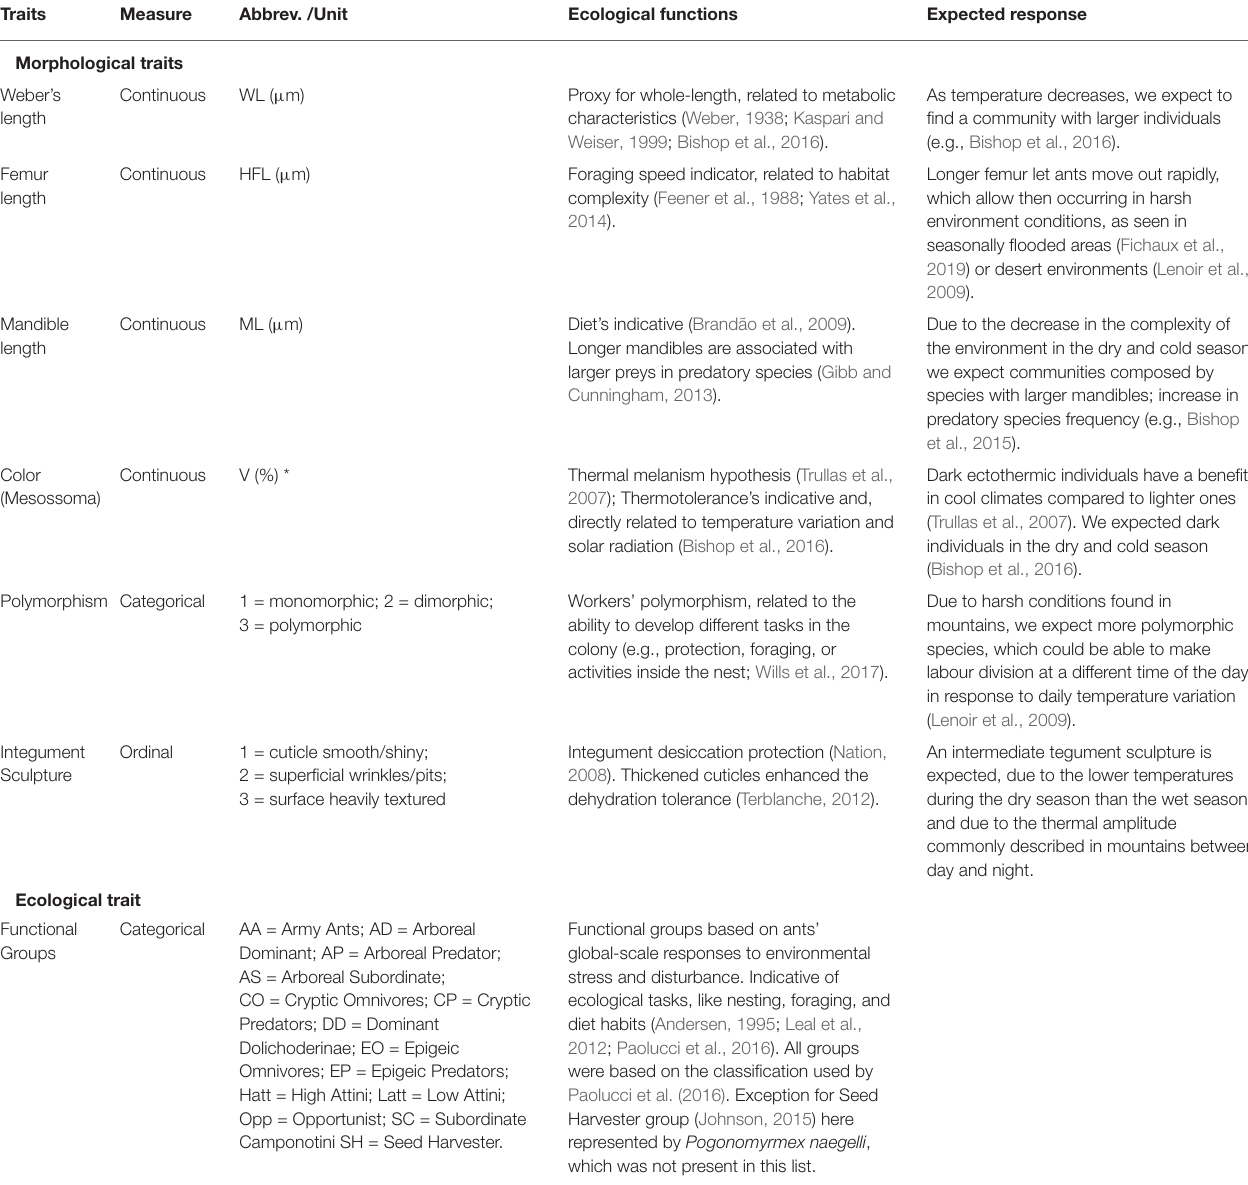
TABLE 1 | List of response functional traits measured (morphological and ecological), their hypothesized ecological functions and the expected response of the traits to environmental change. Traits Measure Abbrev.